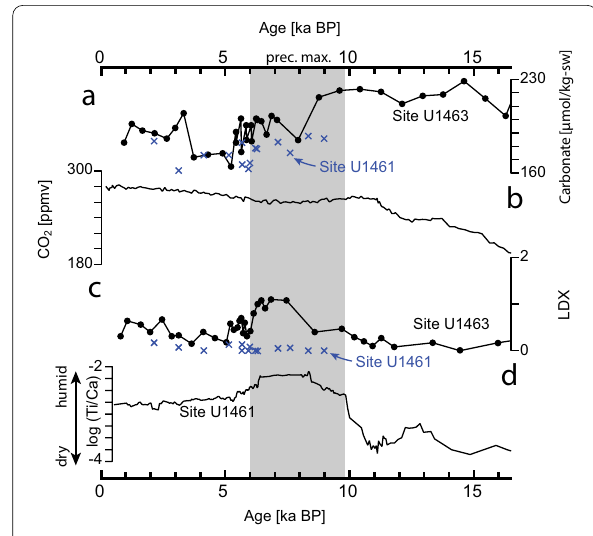
Fig. 6 Selected downcore records of regional and global proxies compared with data from IODP Sites U1461 and U1463. The gray band indicates a regional precipitation maximum on the NWS (Hallenberger et al. 2019; Ishiwa et al. 2019). ( a ) Carbonate ion concentration calculated from δ 13 C values of pteropods. ( b ) Atmospheric CO 2 concentration determined from the Dome Concordia (Antarctica) ice core (Monnin et al. 2001). ( c ) Limacina dissolution index (LDX) for pteropods from Sites U1461 and U1463. ( d ) The log ratio of Ti/Ca, which is a proxy for arid (low values) and humid (high values) conditions in northwestern Australia. Site U1461 (Hallenberger et al. 2019) records the onset of humid conditions after ca . 10